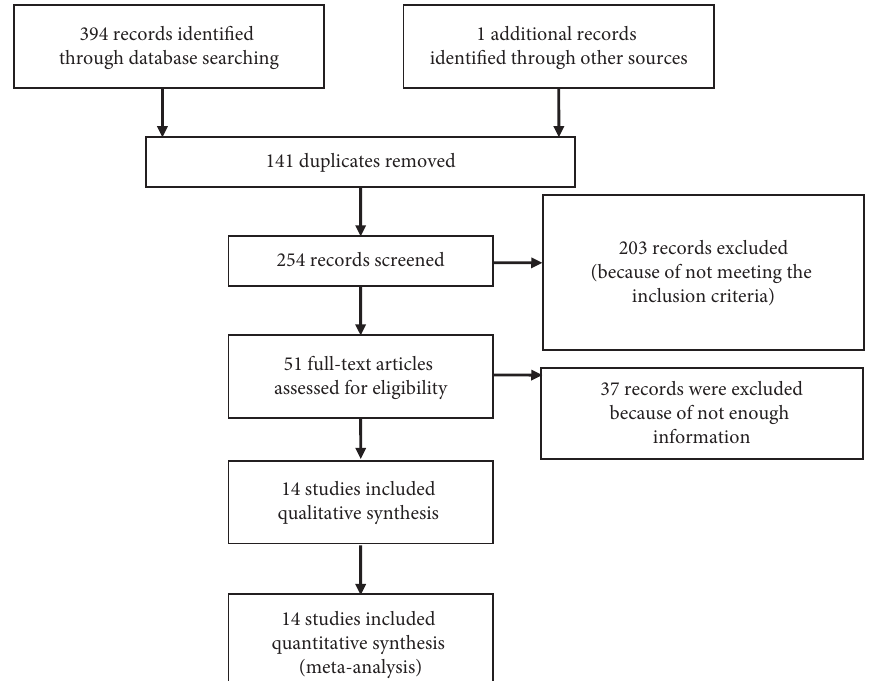
Figure 1: Flowchart of the evaluated studies into meta-analysis.